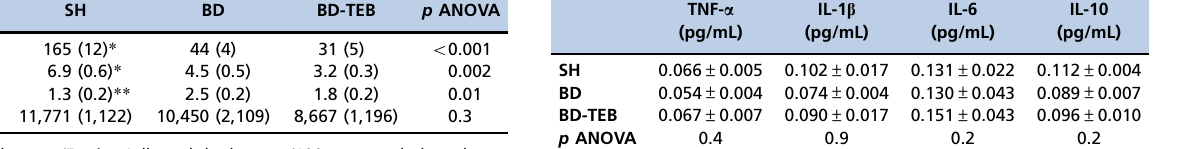
Rollers: leukocytes/5 min; Adhered: leukocytes/100 m m venule length; Migrated: leukocytes/5,000 m m 2 ; WBC: White blood cells/mm 3 . SH: sham-operated rats; BD: brain-dead non-treated rats; BD-TEB: brain-dead rats under thoracic epidural blockade. These measurements were performed 180 min after the surgical procedures. The data are presented as the means ± SEM. * p o 0.01 vs. the other groups. ** p o 0.05 vs. the other groups.